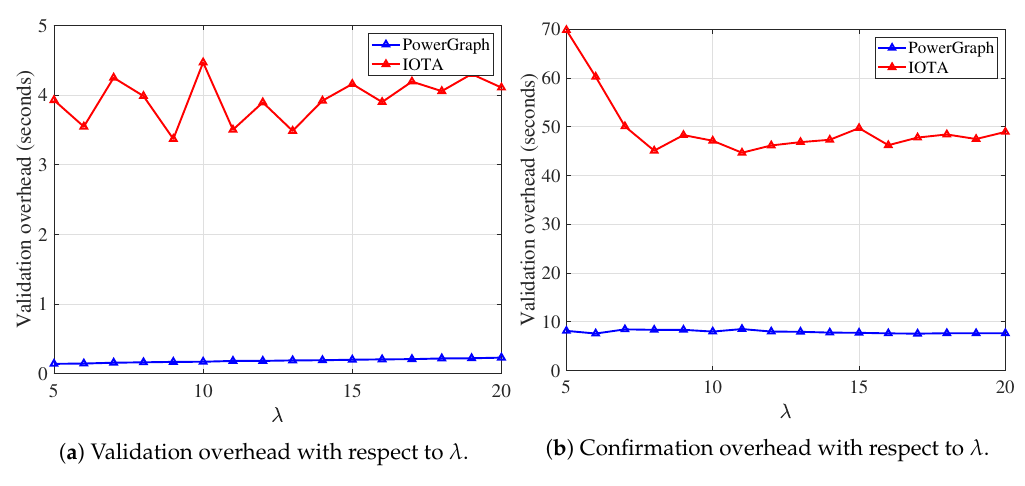
Figure 10. Simulation results with respect to λ .